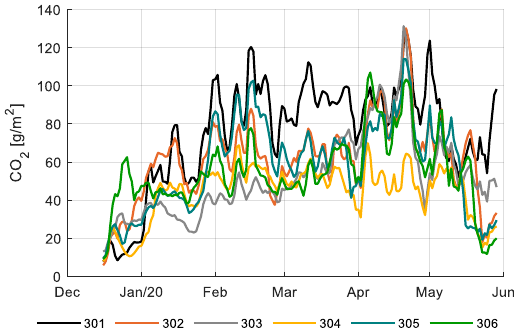
Figure 7. Weekly average CO 2 concentration (ppm) during the light period in different greenhouse compartments (301–306).